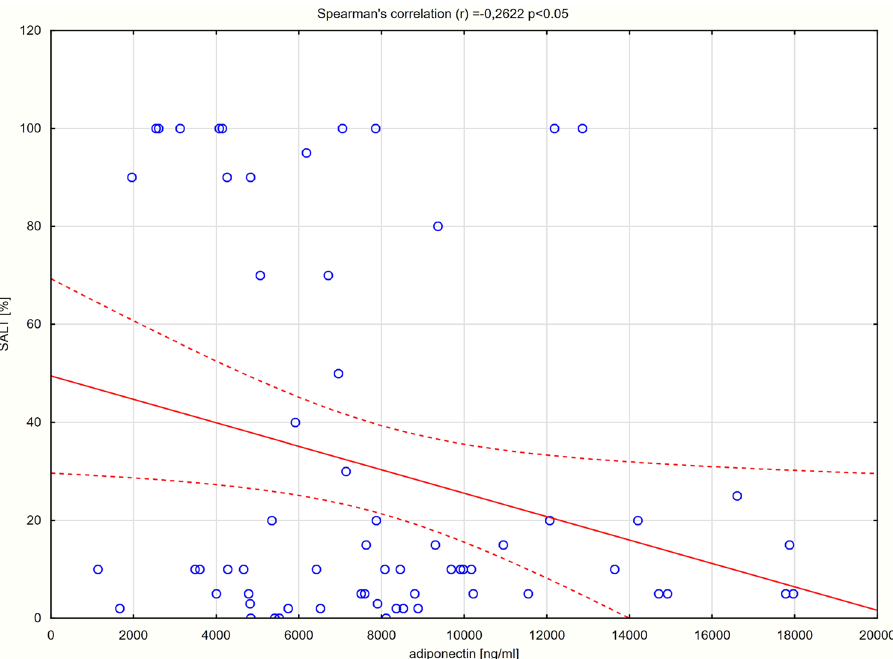
Figure 3. A correlation between the serum concentration of adiponectin and the severity of alopecia